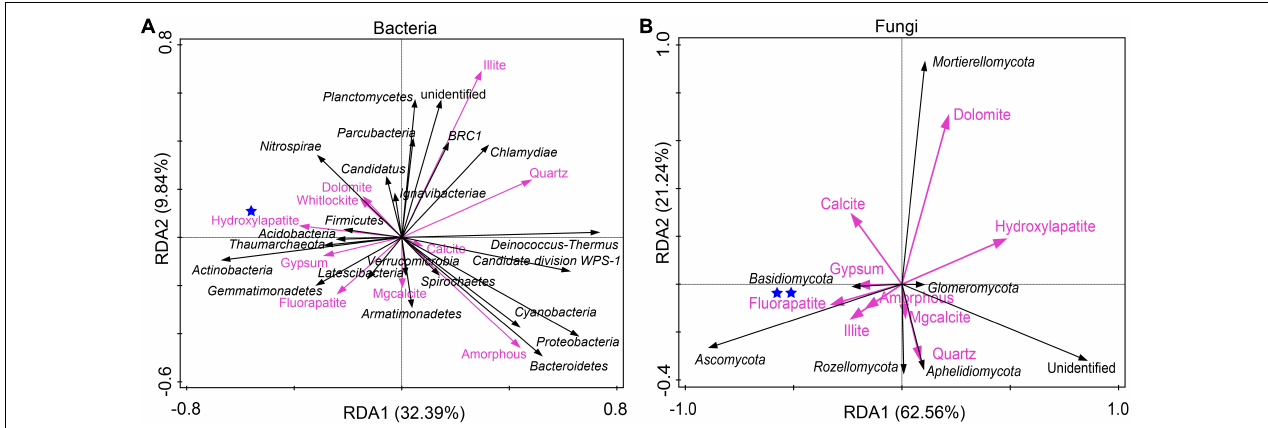
FIGURE 3 | Redundancy analysis of mineral compositions and bacterial communities (A) and fungal communities (B) of the weathered rocks in the Heshang Cave, China. Mineral phases significantly impacting microbial communities were marked with one (with P < 0.05) or two blue stars ( P < 0.01), respectively.